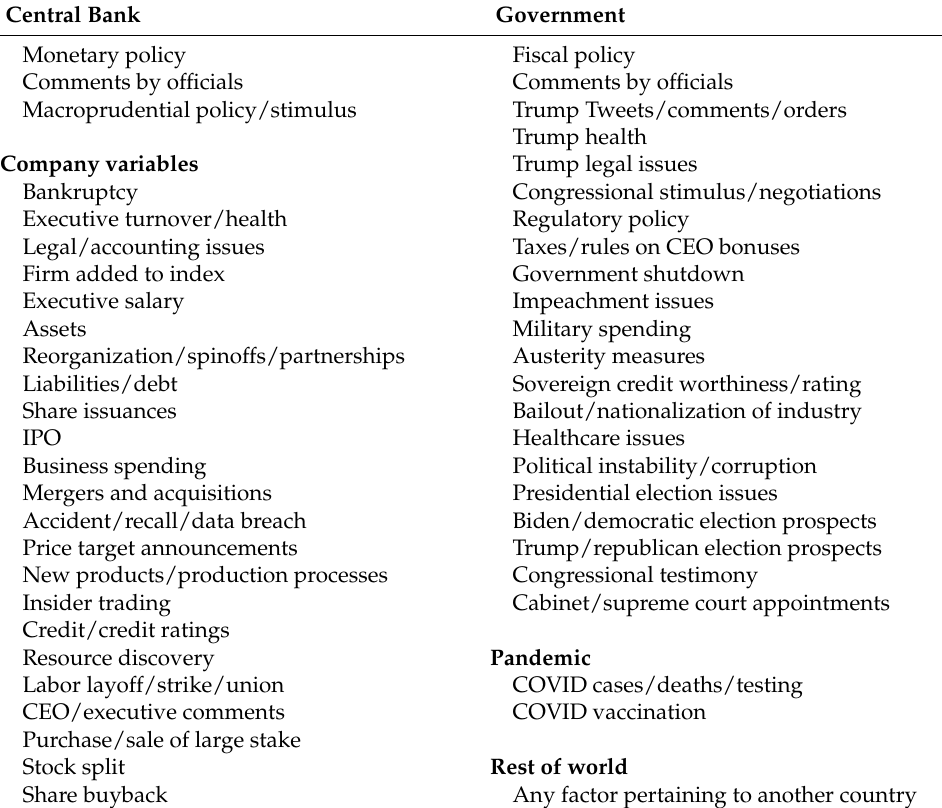
Table 1. KU factor disaggregated